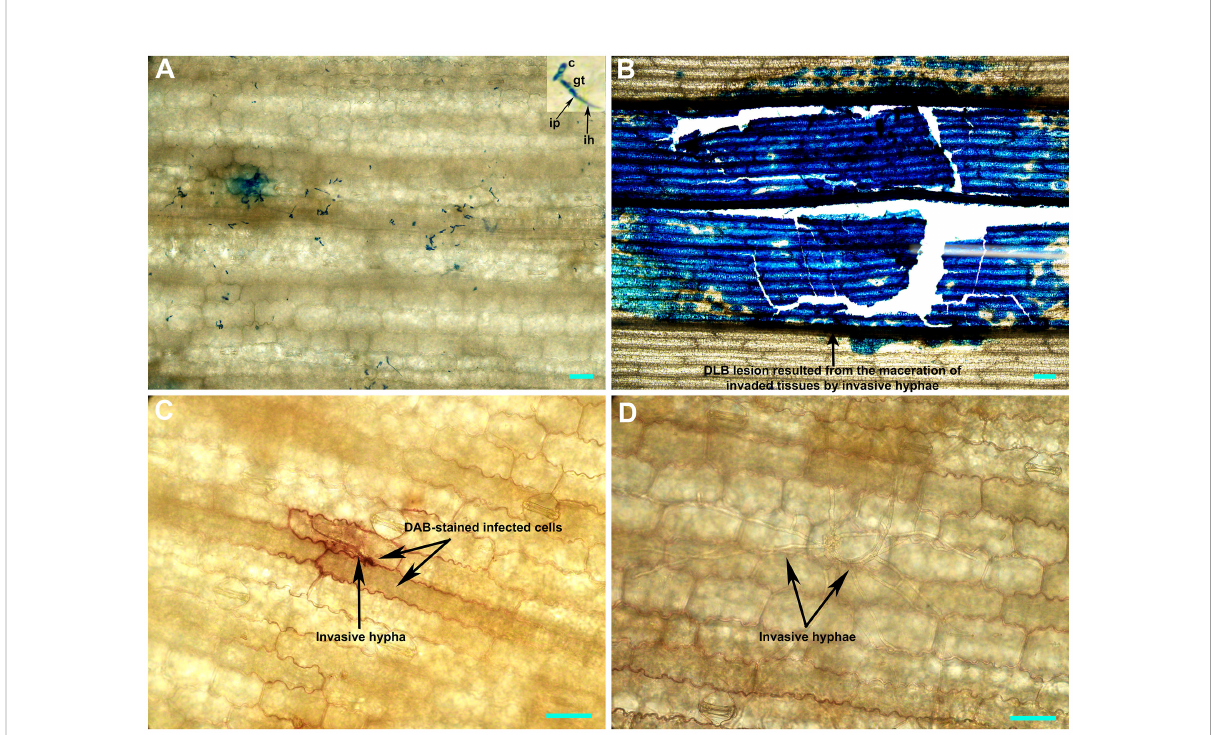
FIGURE 5 Histochemical staining of the Didymella glomerata strain Pj-2-infected tissues of susceptible (P178) and resistant (CML496) inbred lines of maize. The top image panel shows the acidic aniline blue-stained CML496 (A) and P718 (B) leaf tissues, and the bottom image panel illustrates the DAB-stained CML496 (C) and P178 (D) leaf tissues fi ve days post-inoculation. The D. glomerata conidia germinate to form germ tubes, which directly breach the host cell cuticle, presumably via infection pegs. This invasion is restricted to the fi rst infected epidermal cells (A) and leads to the accumulation of H 2 O 2 (a reactive oxygen species; c) in CML496, whereas the invasion in P178 leads to the maceration of infected tissues (B) by invasive hyphae (D) . c, conidia; gt, germ tube; ip, infection peg; ih, invasive hypha; Bars = 20